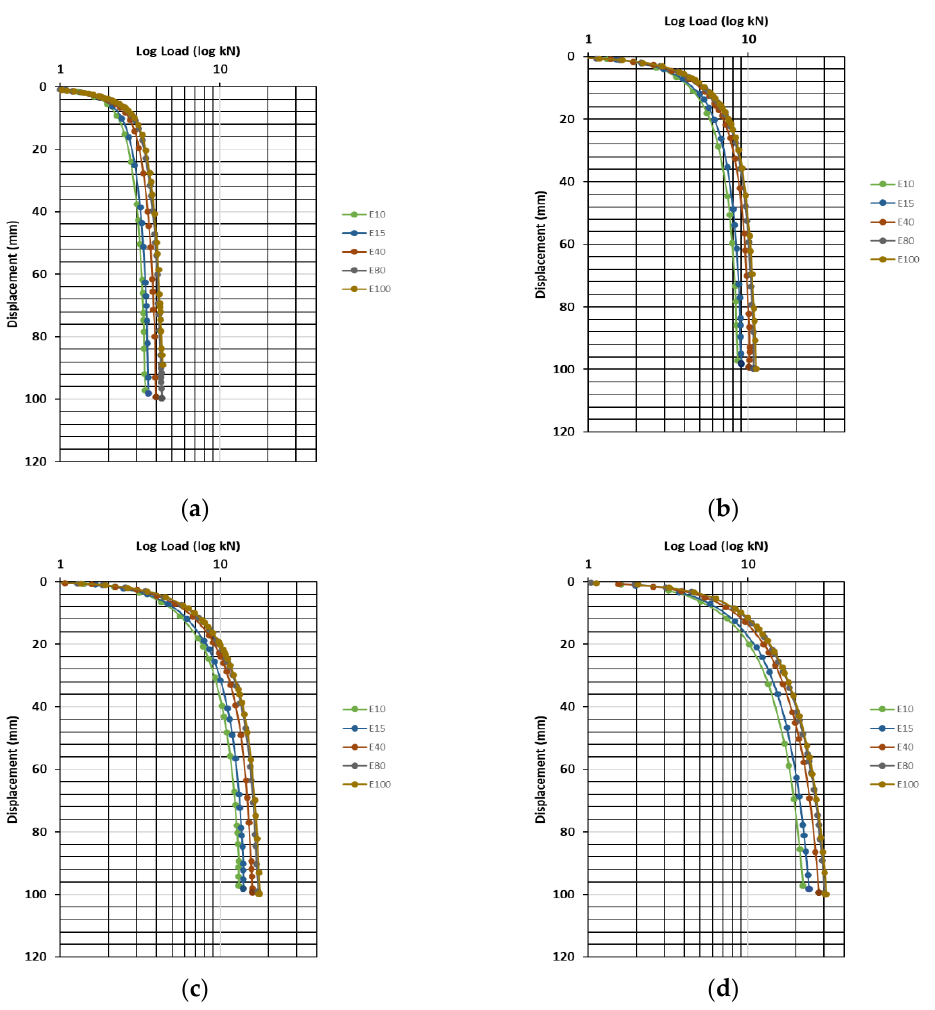
Figure 2. Load versus horizontal displacement for CHSB 0 pile: ( a ) cohesion of 10 kPa; ( b ) cohesion of 30 kPa; ( c ) cohesion of 50 kPa; ( d ) cohesion of 100 kPa. Table 6. Pile foundation capacity in relation to Young’s modulus of soil for CHSB 0